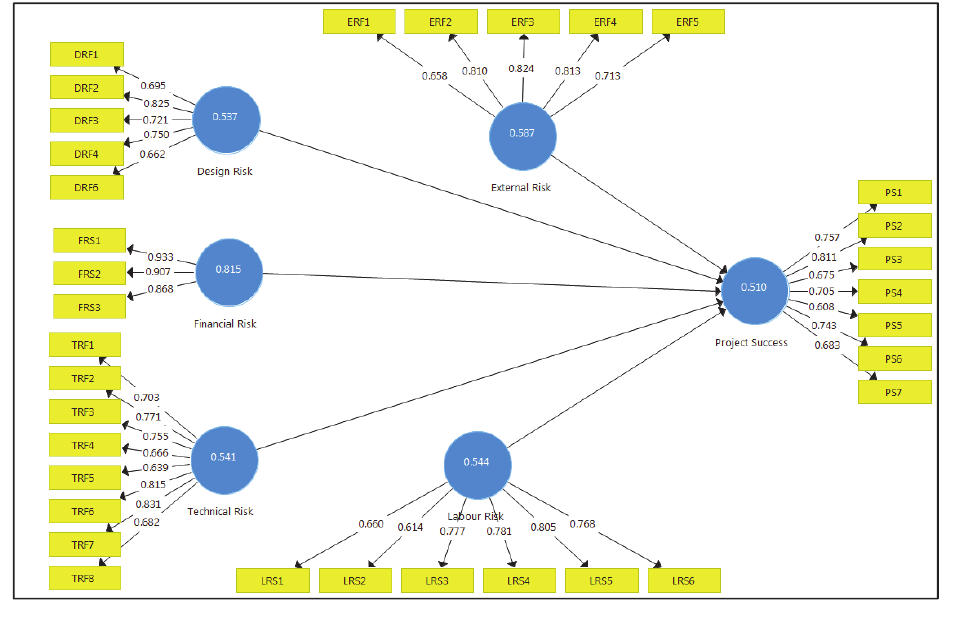
Fig. 2. Framework